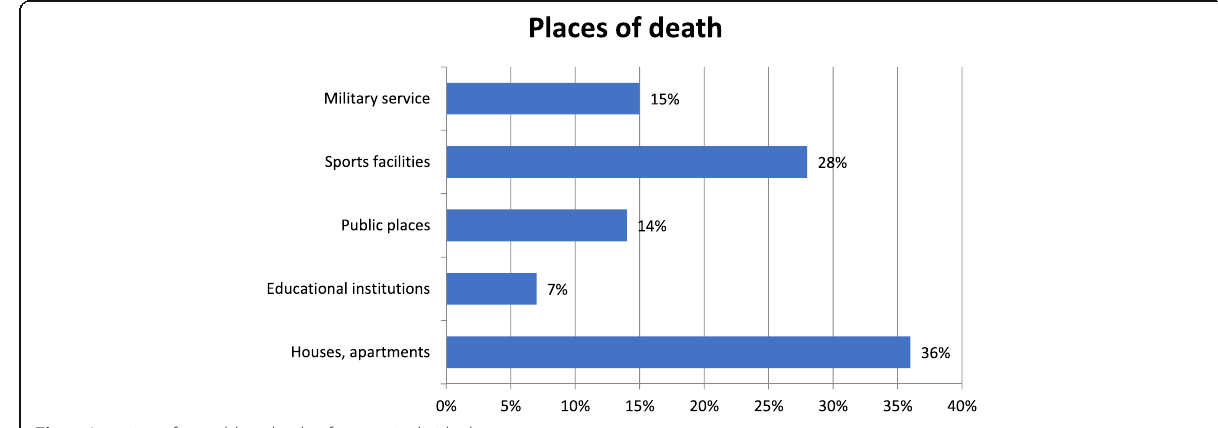
Fig. 1 Locations for sudden death of young individuals